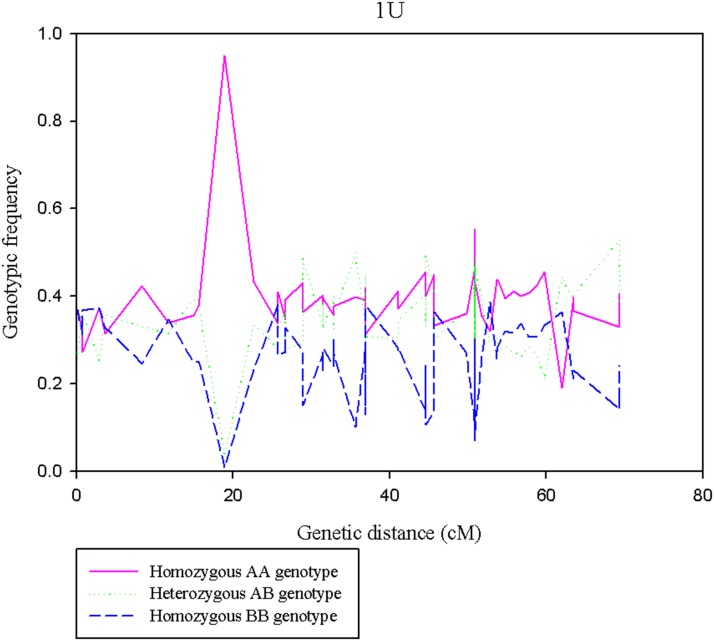
Pattern of genotypic frequencies across regions of chromosome 1U. The y-axis indicates the genotypic frequencies of the three genotypic classes (AA, AB, and BB) for the corresponding genetic position on the x-axis.